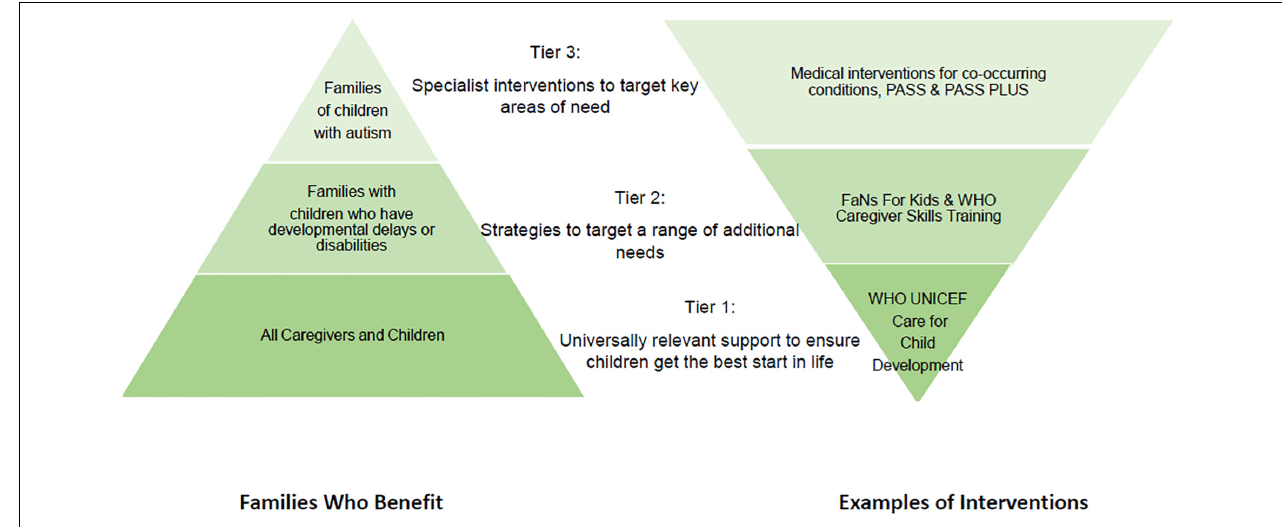
FIGURE 2 | Stepped care approach to supporting children based on the WHO Nurturing Care